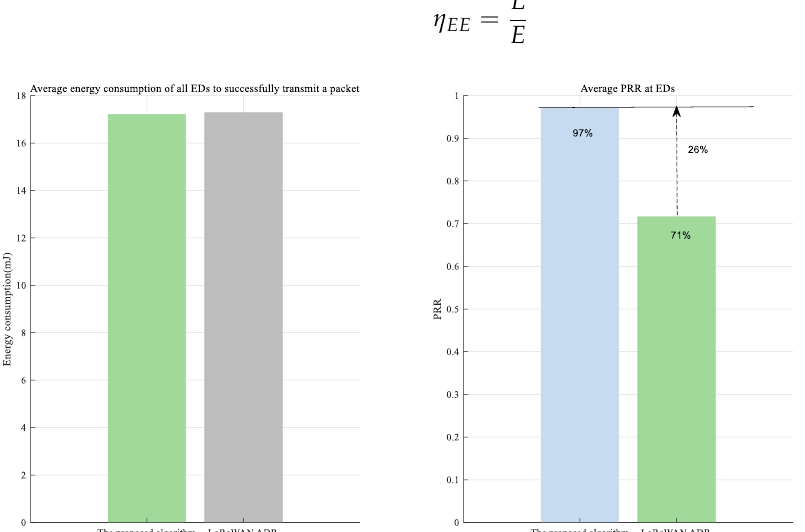
Figure 19. Comparison of the different algorithms.